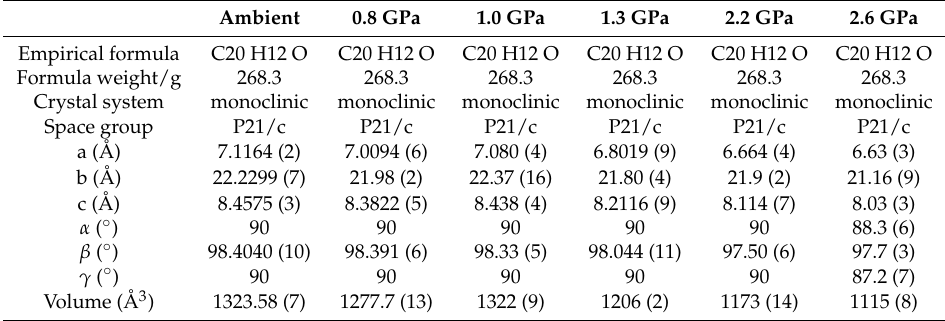
Table 4. Experimental details. The triclinic setting ( α and γ cell angles diverging from 90 ◦ ) at 2.6 GPa resulted from inferior data quality at this pressure point (broadening of diffraction spots) and does not indicate a phase